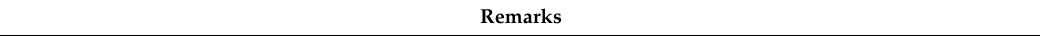
Table A4. Online Questionnaire during the educational workshops (Part